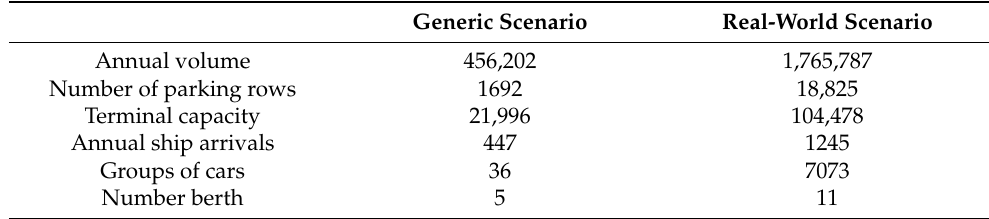
Table 3. Comparison of the generic and real-world